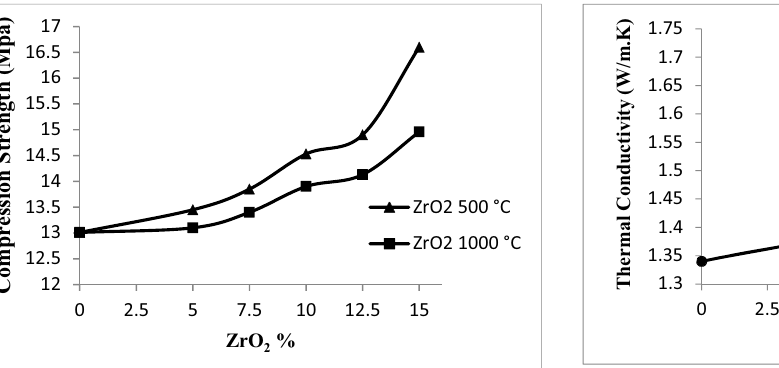
Figure 10: Thermal conductivity for various ZrO 2 additions in refractory